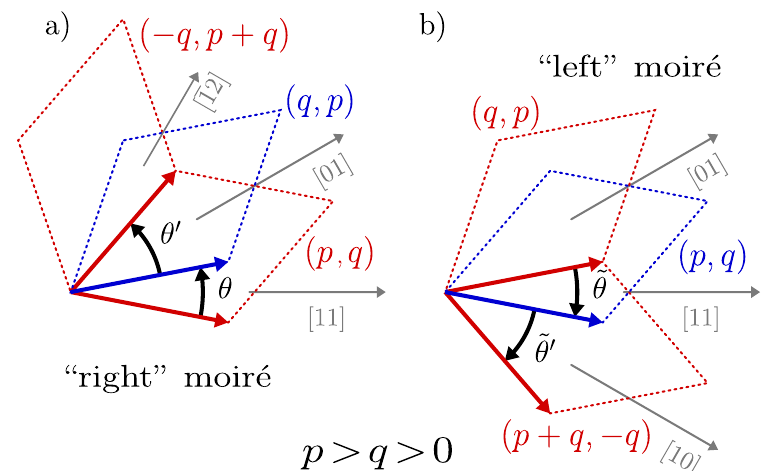
Figure 6: a) The angles θ and θ ′ , based on the ( q , p ) geometries (that are used in the main article). b) The angles ˜ θ and ˜ θ ′ corresponding to the mirror images of the previous ones. They are based on the ( p , q )